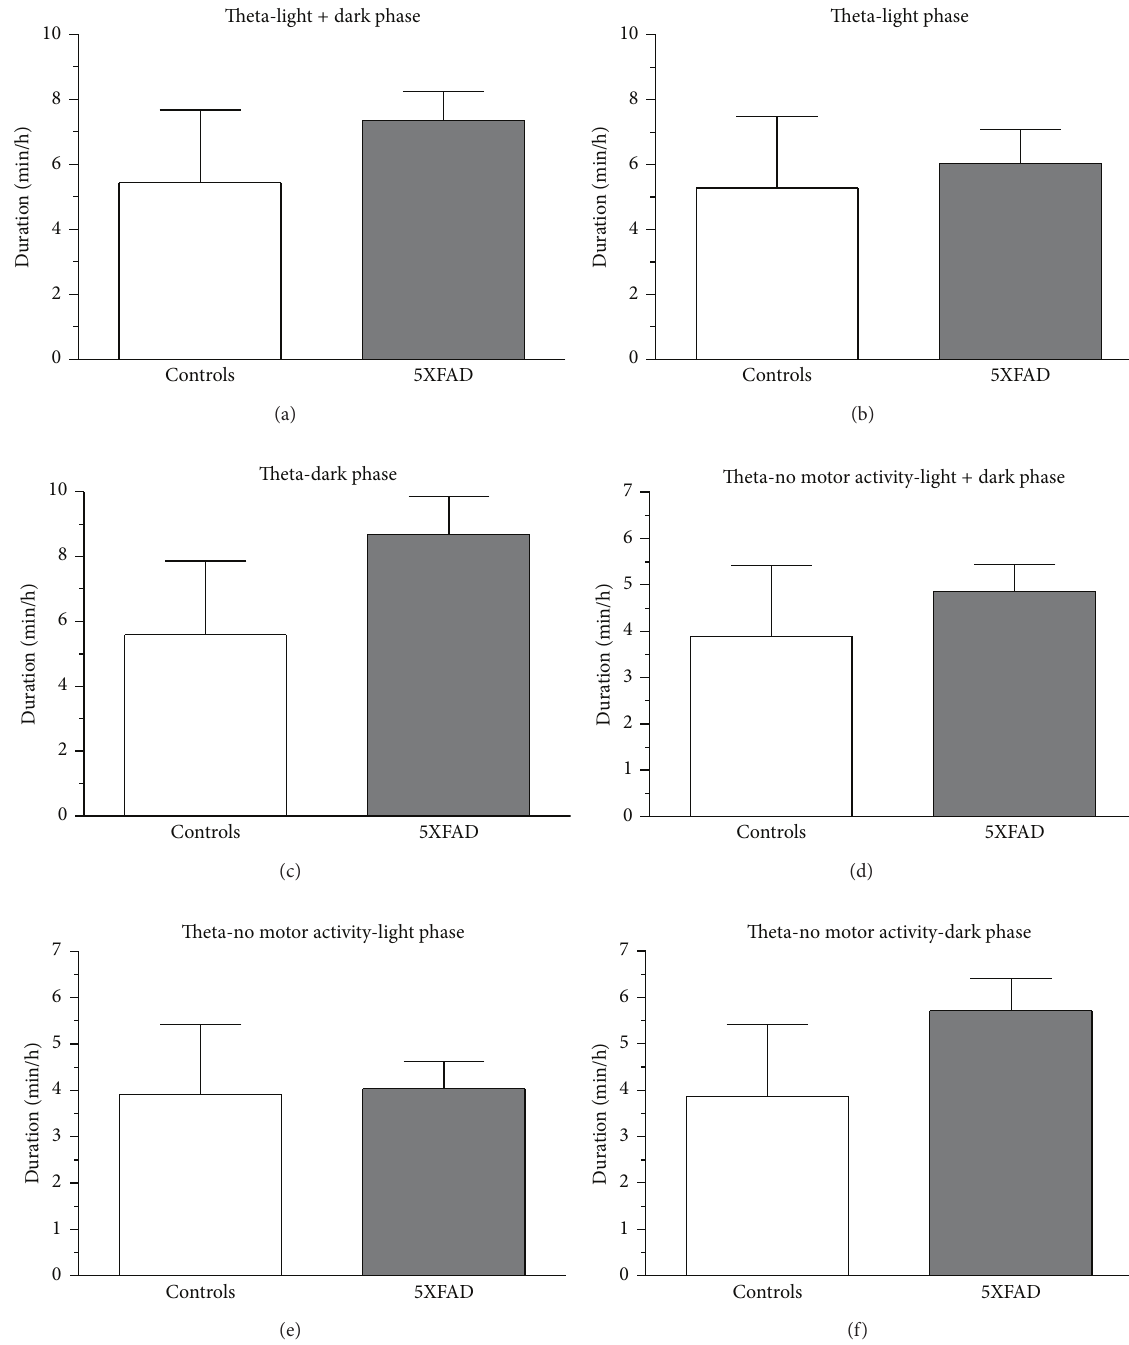
Figure 6: Characteristics of theta duration in control and 5XFAD mice. The theta-alpha band was analyzed using a time-frequency approach. Behavioral artefacts were removed using an algorithm as described above. Theta-segments (10s) were summed to determine theta duration (min/h). Theta duration was calculated for both genotypes for the total observation period (a) and the light (b) and dark (c) phases, respectively. Total and phase-specific analysis was also done for nonmotor activity ((d)–(f)) and motor activity (not shown). Mean values suggest an increase in theta duration in 5XFAD mice, particularly during the dark phase ((c),